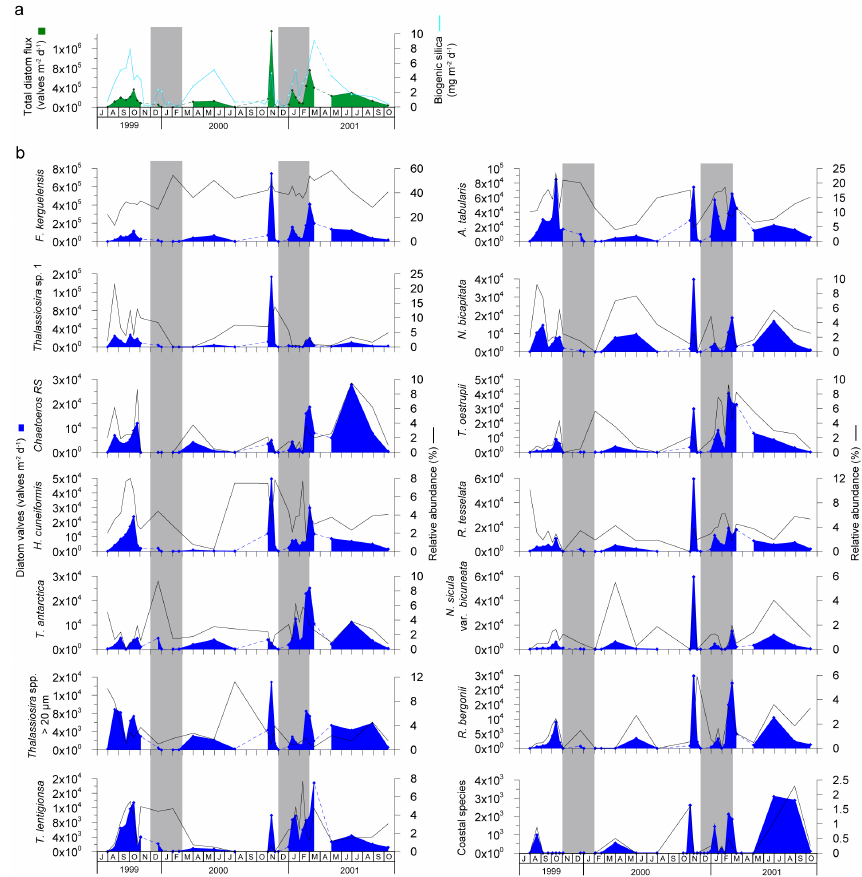
Figure 4. Temporal variability of (a) total diatom flux and biogenic silica and (b) flux and relative contribution of the main diatom species at 1000m at the 47 ◦ S site for the period July 1999–October 2001.